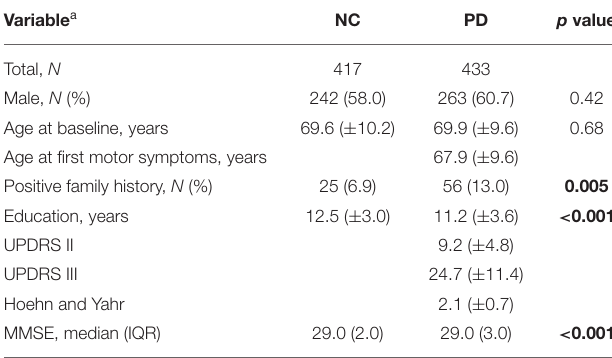
TABLE 1 | Baseline demographic and clinical characteristics of patients and controls included in